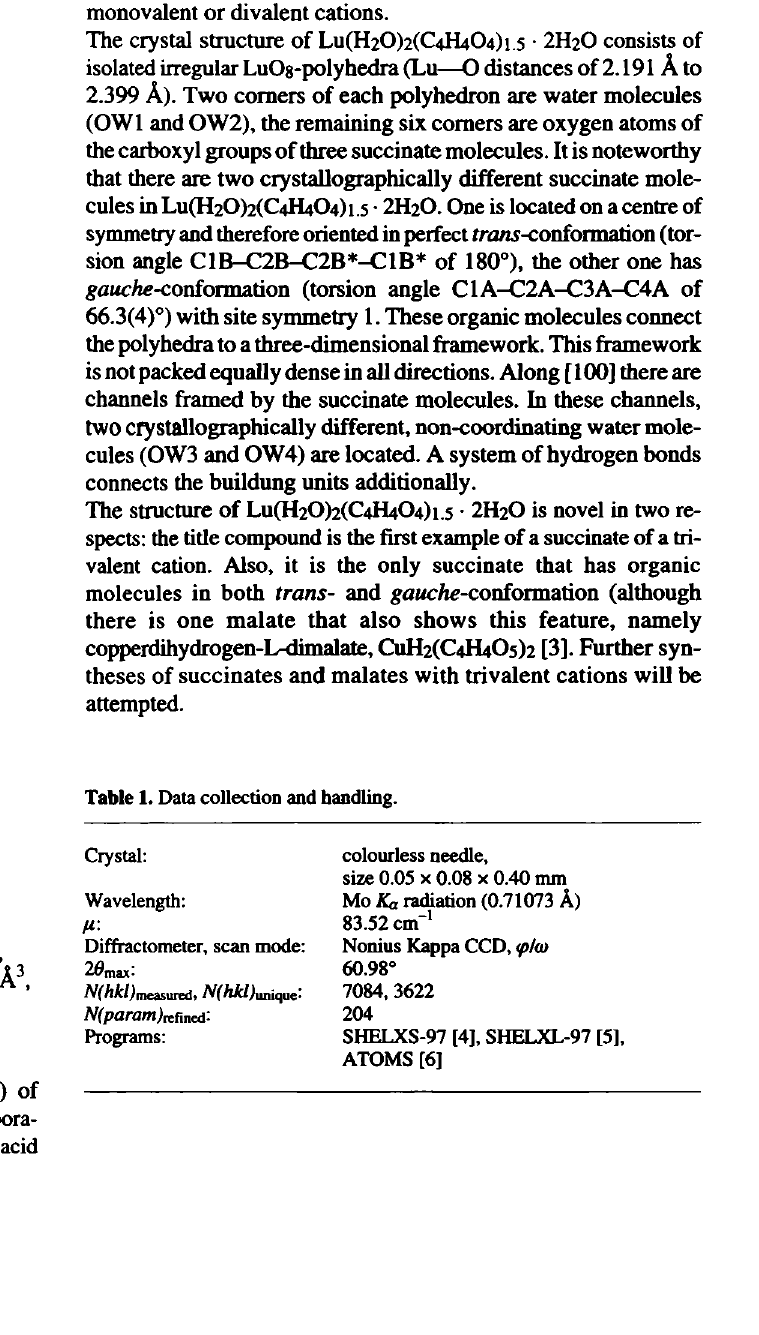
Table 1. Data collection and handling.